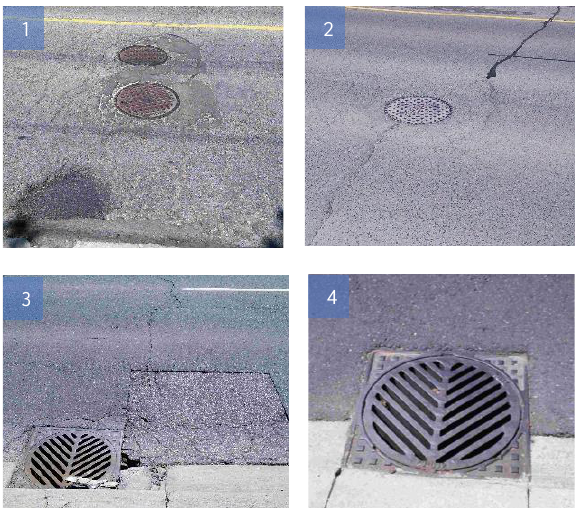
Figure 6. Captured photos from studied road surface anomalies The spatiotemporal data processing step was focussed on integrating the multiple probability distributions of multi-time detections of any road surface anomaly. They were grouped as a cluster resulting from the cluster assigning process to update the level of the severity probability distribution for a detected anomaly as more evidence becomes available. Figure 7 represents the 3D view of the results by integrating road surface anomalies according to their classes which have high probability. According to Figure 7, the height of each anomaly indicates the severity level of the anomaly (with high probability), which were sensed and integrated after five repetitions of the road surveys. The anomalies which were clustered in Class 1 (first level of severity) with higher probability specifies the least level of severity which were mainly caused by small cracks, even manhole covers, or road joints. However, the anomalies, which were clustered in other classes (i.e., Class 1, Class 2 and Class 3) with higher probabilities, resulted from potholes, big cracks, or uneven manhole covers and should be inspected for further verification.